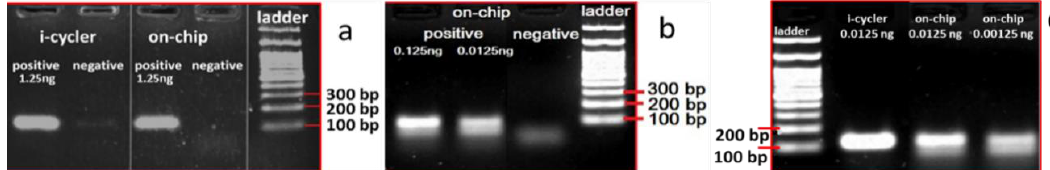
Figure 5. Agarose gel electrophoresis images depicting the (117 bp) products from the conventional thermocycler and the on-chip amplification for purified genomic Salmonella DNA using 4 different DNA concentrations, from 1.25 ng ( a ), to 0.125 and 0.0125 ng ( b ), down to 0.00125 ng ( c ), per 25 μL PCR reaction. The on-chip experiments were performed one at a time, in a microfluidic chamber lying in the central area of the fluidic chip, in thermal contact with a thick PCB microheater chip.